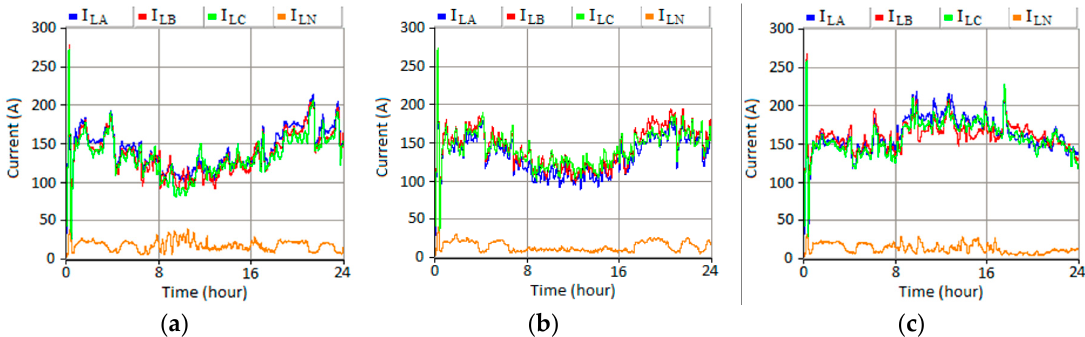
Figure 12. Phase neutral current and load neutral current of: ( a ) MG1; ( b ) MG2; ( c ) MG3.